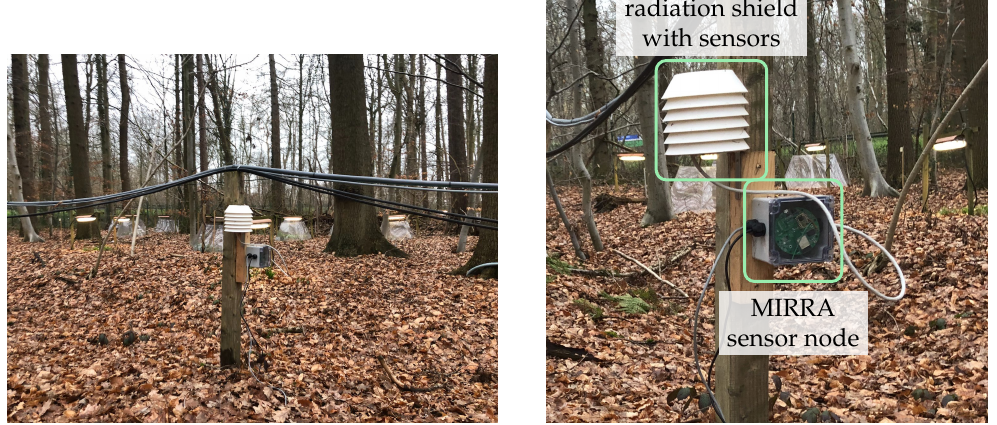
Figure 2. A Photosynthetically Active Radiation (PAR) sensor, was not used because it